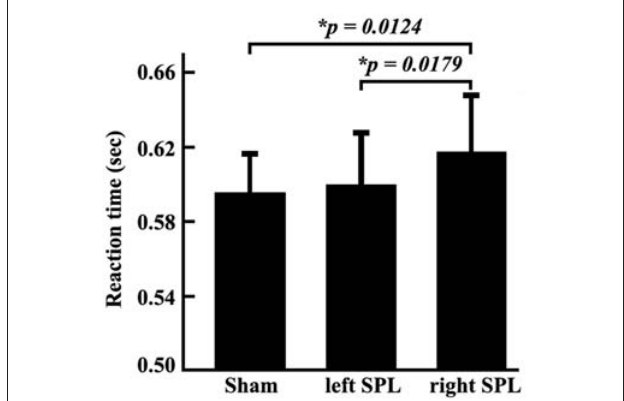
FIGURE 2 | Reaction times of behavioral tests in the three conditions. The experiment was a block design containing three conditions: sham stimulus; stimulus to the left SPL; and stimulus to the right SPL. During each condition, the reaction time of each subject was recorded. Then, mean reaction times and standard error of the mean in each condition was calculated. The paired two-tailed t -tests were performed on the reaction time, and the threshold was set at p < 0.05 for